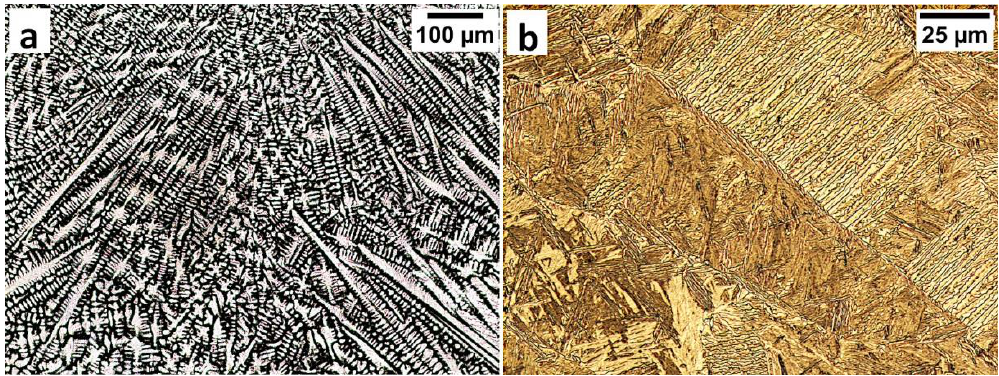
Figure 5. The structure of the fusion zone in the area “A” (marked in Figure 4). ( a ) The columnar, dendritic solidify structure. Etched by saturated picric acid solution, lm. ( b ) Lath morphology of bainite. Etched by nital, LM.